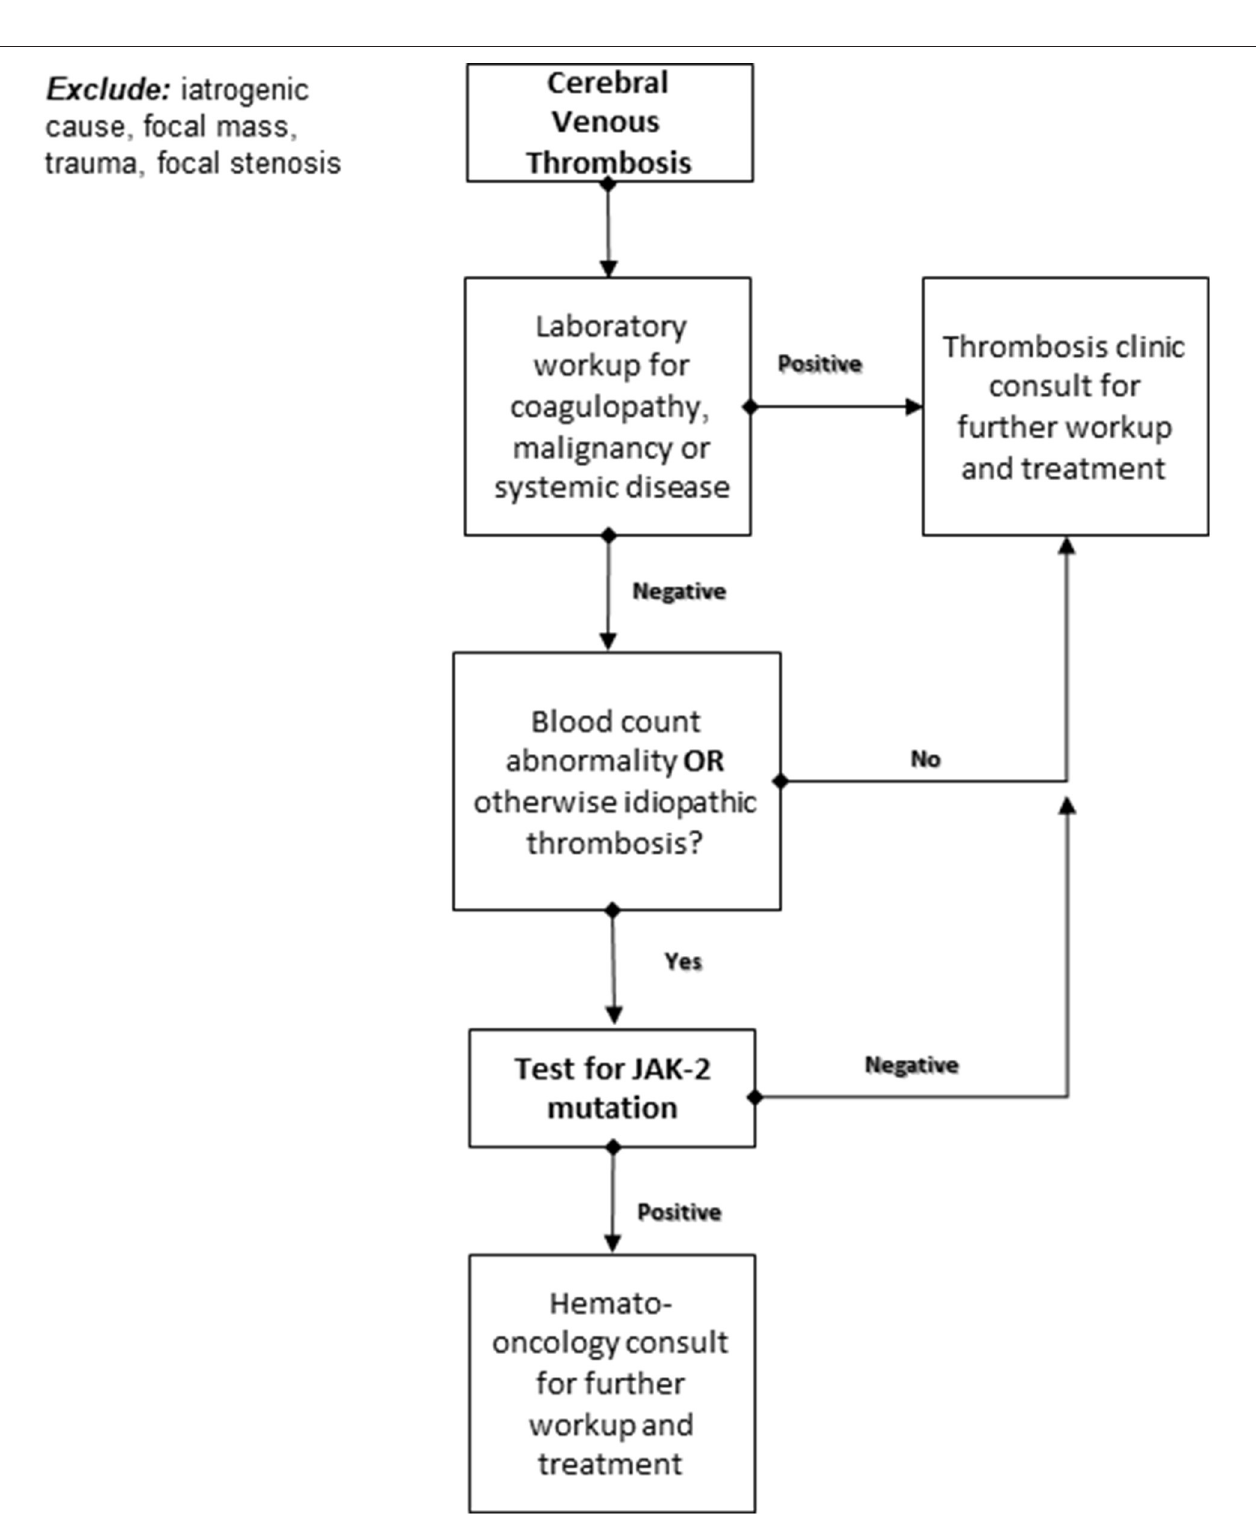
FIGURE 1 | Proposed decision-making algorithm for JAK-2 somatic mutation testing following an acute cerebral venous thrombosis.